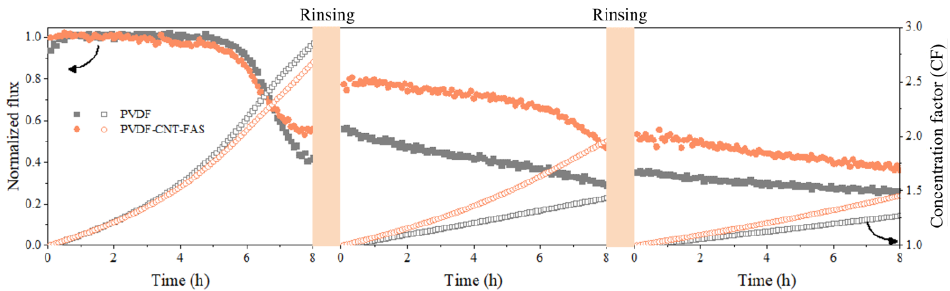
Figure 2. The normalized flux and concentration coefficient of the concentration of the real shale gas wastewater in MD, with initial fluxes of 23.6 and 22.92 kg/(m 2 ∙h) for the PVDF and PVDF-CNT-FAS membranes, respectively.